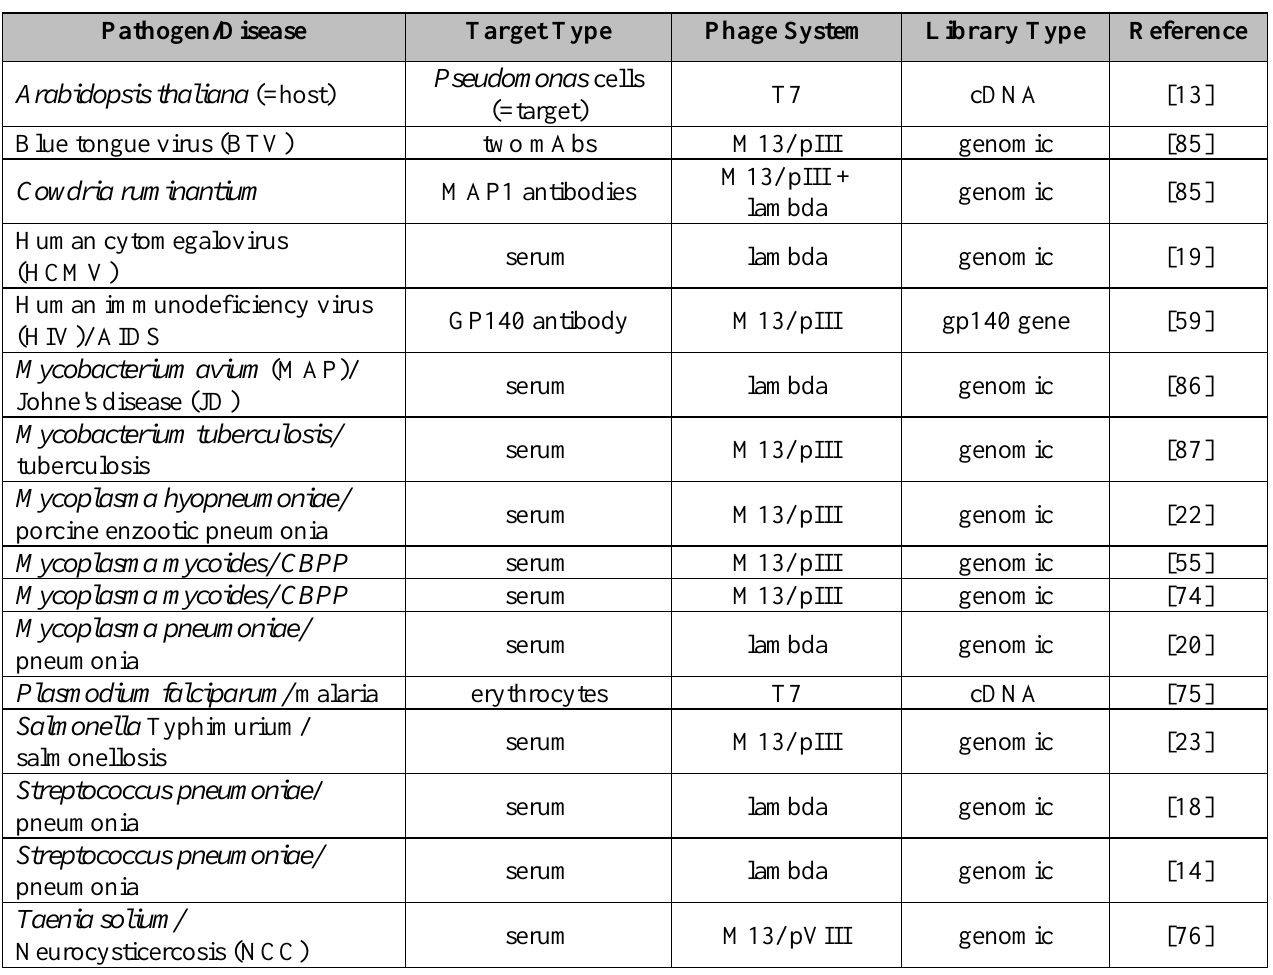
Table 1. Selected oligopeptide phage display libraries used for pathogen